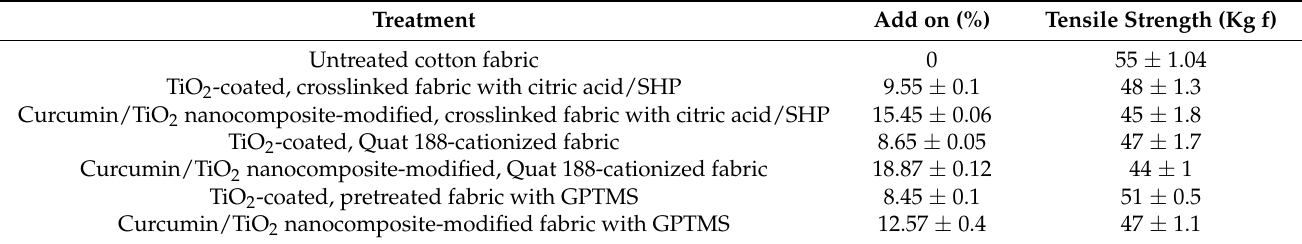
Table 3. Add-on measurements and tensile strength with standard deviations of treated cotton fabric. Treatment Add on (%) Tensile Strength (Kg f) Untreated cotton